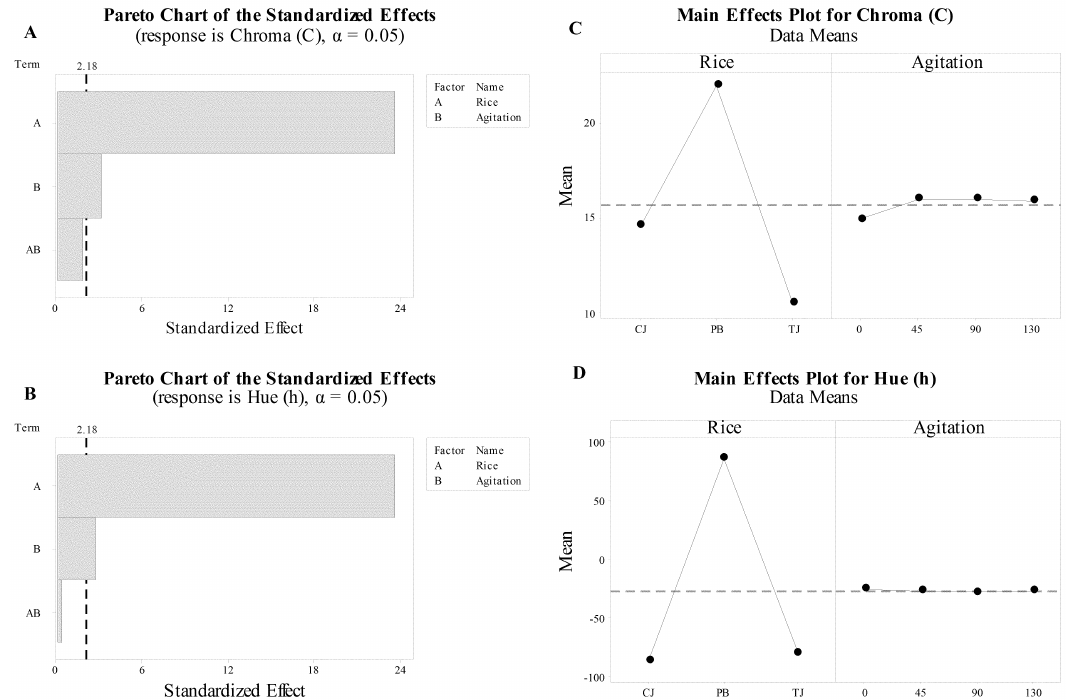
Figure 4. The analysis of the full factorial design presented as Pareto and main e ff ects plots for chroma Figure 4 . The analysis of the full factorial design presented as Pareto and main effects plots for Chroma (C: (C: ( A , C ), respectively) and hue (h: ( B , D ) A and C, respectively) and hue (h: B and D, respectively).